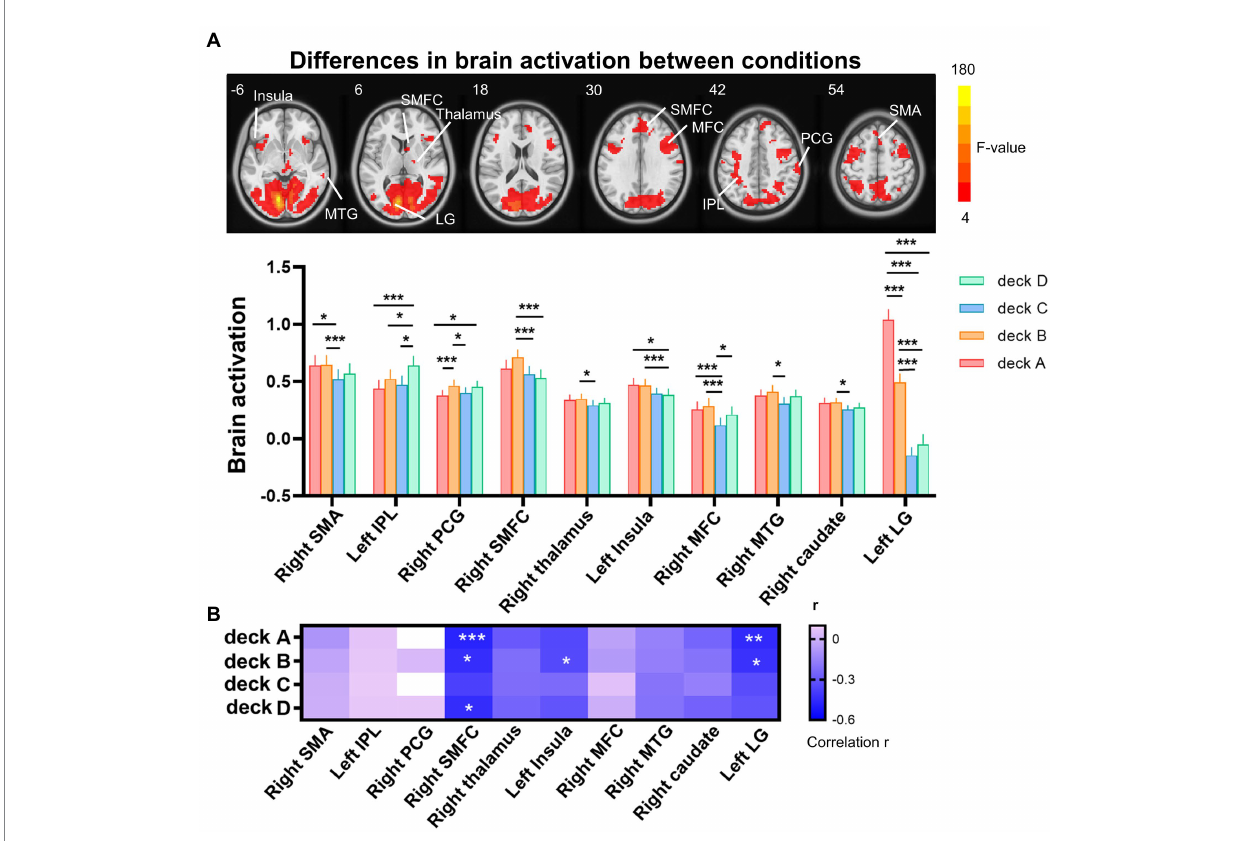
FIGURE 3 Differences of brain activation across the four decks during the IGT. (A) The one-way repeated measures ANOVA showed significant differences of brain activation corresponding to the four decks in the right SMA, left IPL, right PCG, right SMFC, right thalamus, left insula, right MFC, right MTG, right caudate, and left LG. (B) For each deck, significant correlations between brain activation and age were labeled with asterisks, controlled for MoCA, GM, and head motion (FDR corrected p < 0.05). The heat map of partial correlation coefficients exhibits that age-effect was mainly in disadvantageous decks relative to advantageous decks. IPL, inferior parietal lobe; LG, lingual gyrus; MFC, middle frontal cortex; MTG, middle temporal gyrus; PCG, postcentral gyrus; SMA, supplementary motor area; SMFC, superior medial frontal cortex. * p < 0.05; ** p < 0.01; *** p <